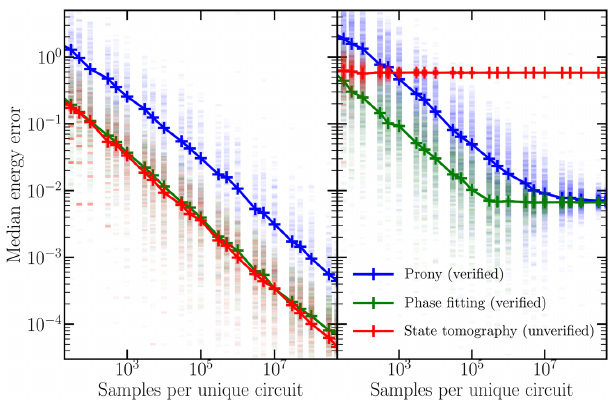
FIG. 7. Convergence of the estimation of a single point in a four-site transverse-field Ising model with the number of sam- ples taken, using verified phase estimation processed either with Prony’s method (blue) or by fitting known phases to the phase function (green), or standard partial state tomography (red) on individual Pauli terms. Left: convergence in the absence of error. Right: convergence in the presence of 1% depolarizing error per qubit per moment. In each subfigure we plot the median energy error (crosses and lines) over 200 simulations, which are plotted themselves behind (faint